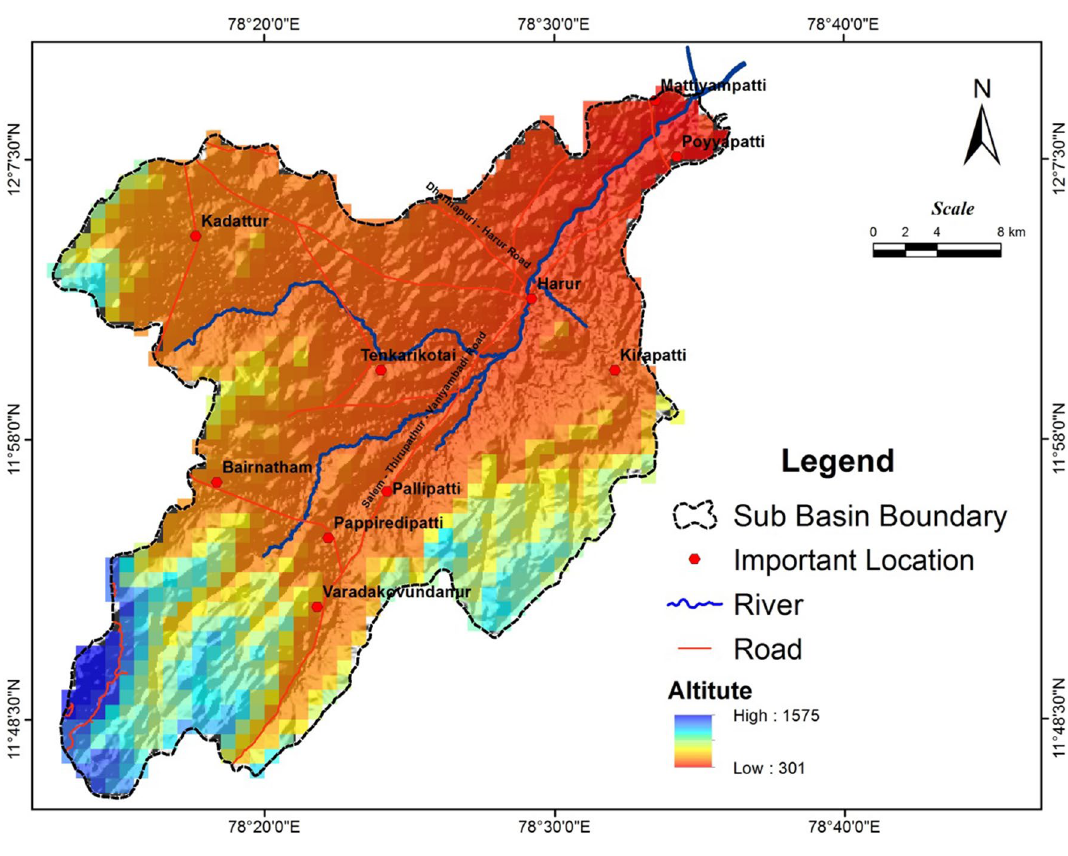
Fig. 11 Spatial variation of Interpolation of altitude map